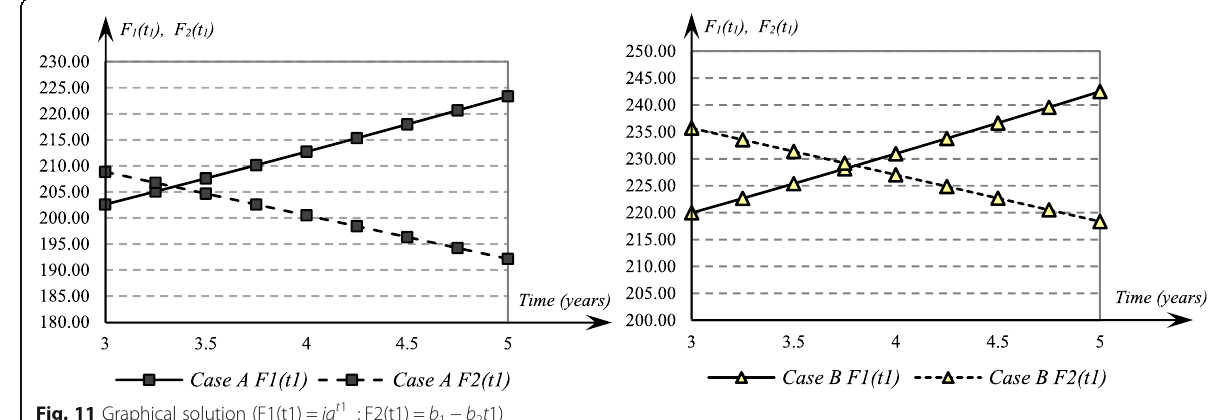
Fig. 11 Graphical solution (F1(t1) = ia t 1 ; F2(t1)= b 1 − b 2 t